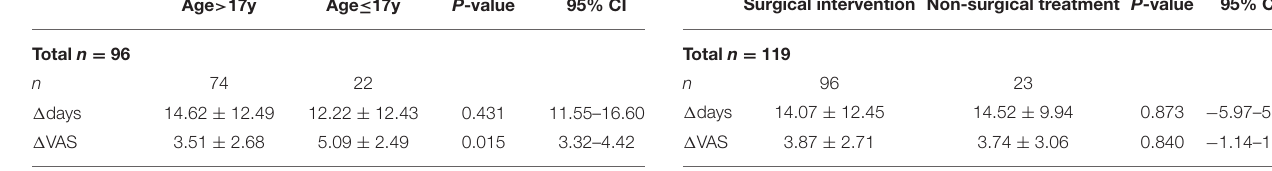
TABLE 8 | Division by surgical intervention/conservative treatment with changes in the frequency ( 1 days) and intensity of headaches ( 1 VAS) after a long-term